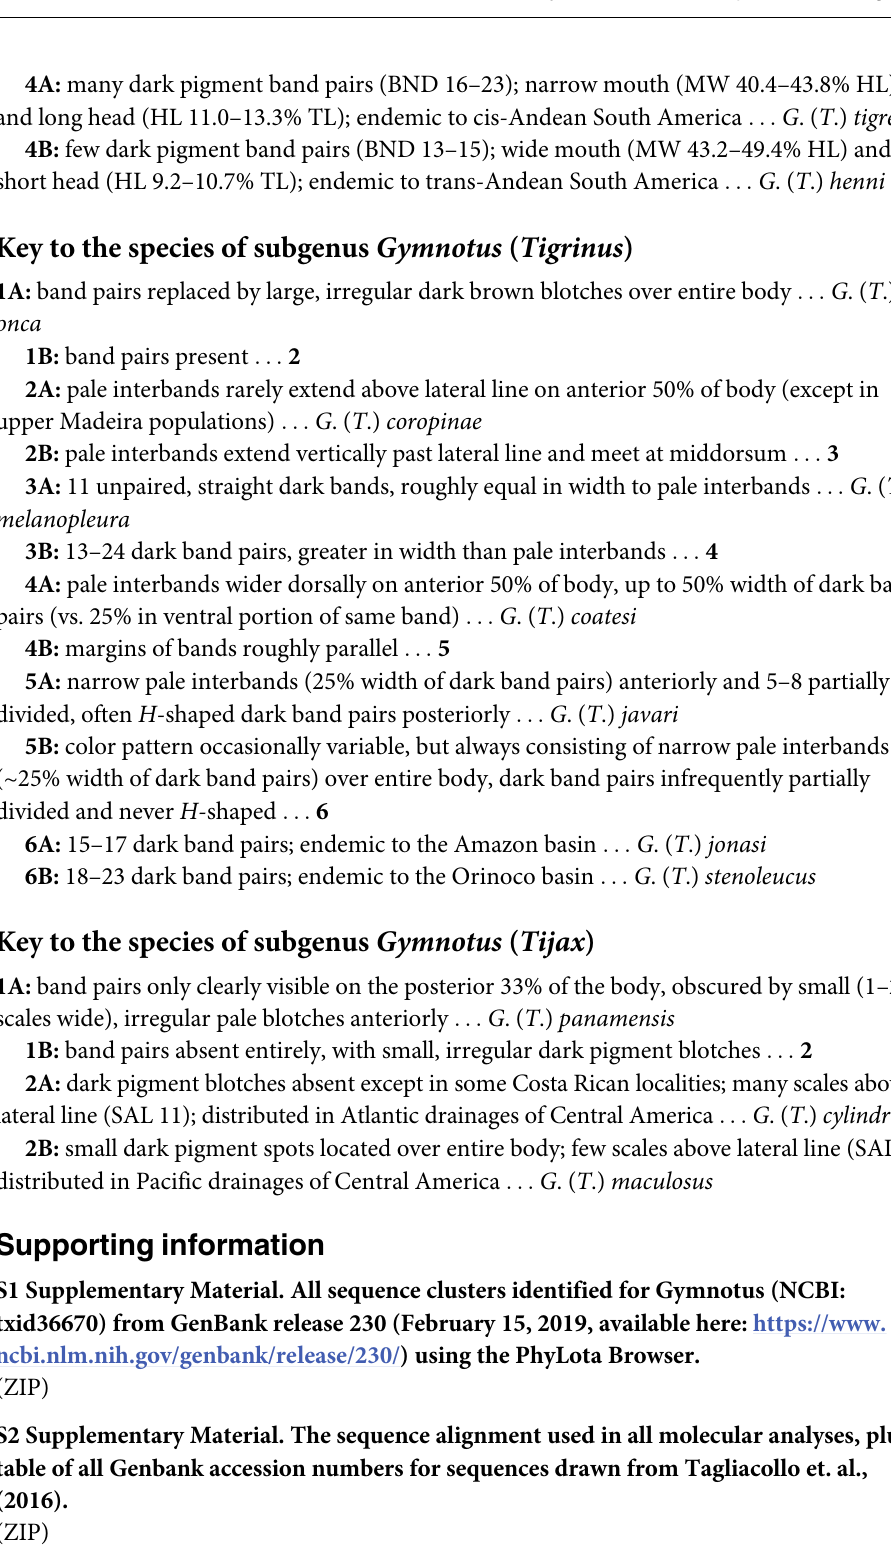
table of all Genbank accession numbers for sequences drawn from Tagliacollo et. al.,